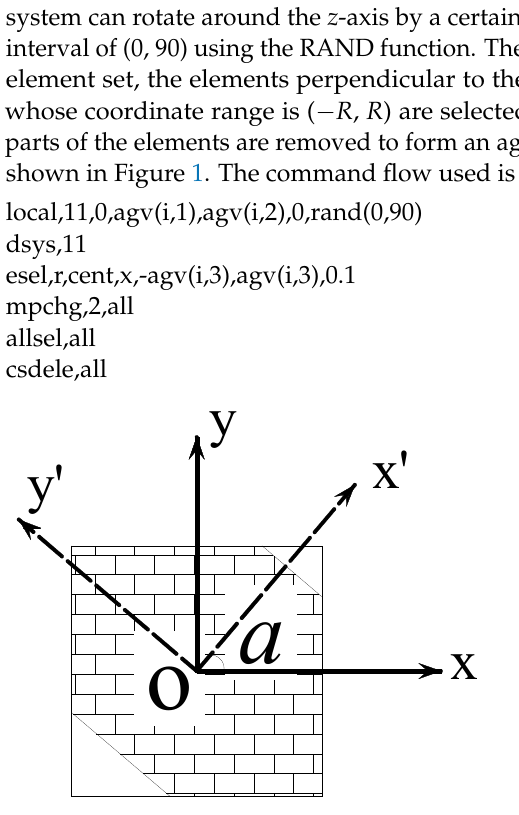
Figure 1. Polygonal aggregate element selection schematic diagram.